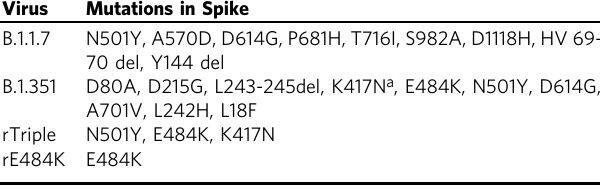
Table 1. For this microneutralization experiment, we included samples from individuals who had recovered from natural infection, both. Post-vaccination sera were obtained from six individuals who BNT162b2, three of which had previous exposure to SARS-CoV-2